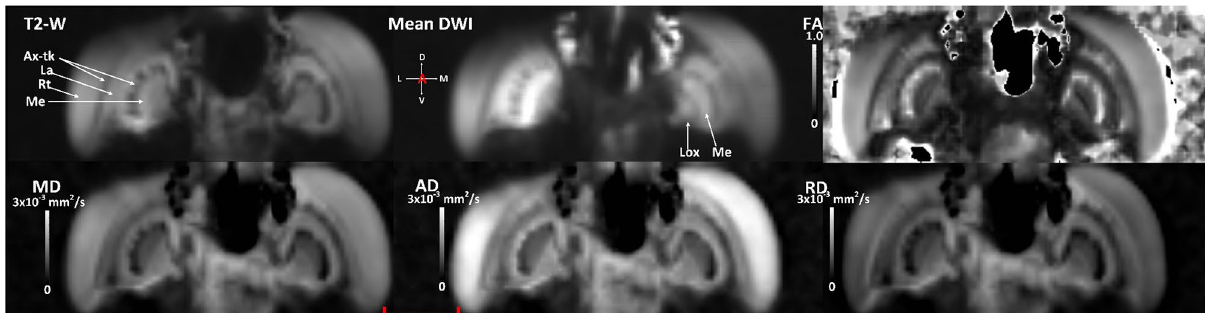
Figure 3. Coronal slice, anterior view from live sample illustrating anatomical structures and their diffusivity profile using qualitative and quantitative scalar maps. T2-W and mean DWI based contrasts are qualitative in nature and their pixel/voxel intensity scales are arbitrary. FA, MD, AD and RD are quantitative scalar maps, in this study, they were derived from DKI model. In T2-W map, regions exhibiting longer transverse relaxation (T2-relaxation) are hyperintense and regions exhibiting shorter transverse relaxation are hypointense. In averaged DWI based map, regions of low diffusivity are hyperintense and regions of high diffusivity are hyperintense. FA measures the degree of directional (diffusivity) anisotropy and has a range between 0 and 1. High FA values suggest higher directionality of diffusion. MD represents the mean diffusion rate within a voxel, with higher values representing increased diffusivity or isotropy. AD represents the rate of diffusion along the principal diffusion direction. RD represents the rate of diffusion transverse to the principal diffusion direction. The range of MD, AD and RD is from 0 to 3 × 10 –3 mm 2 /s. Ax-tk axonal tracts, La lamina, Lox lobula complex, Me medulla, Rt retina. Scale bar 500